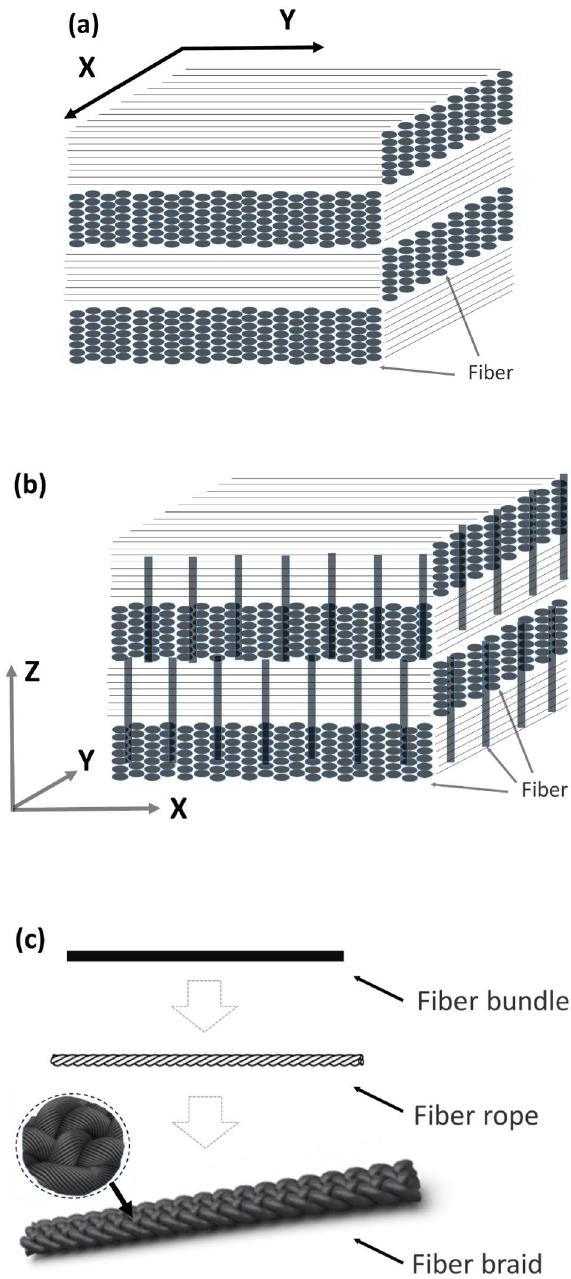
Figure 1. Architecture of preform for C/C composites, ( a ) 2D-C/C composites; ( b ) 2.5D-C/C composites; ( c ) 3D-C/C composites,